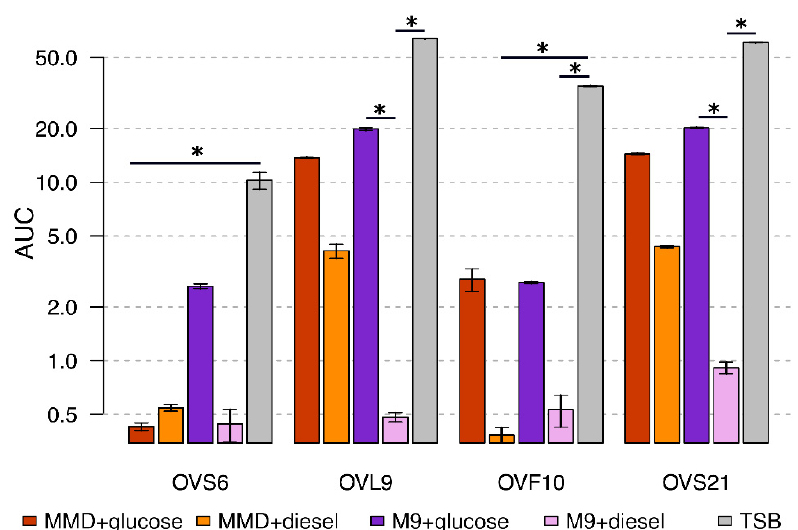
Figure 1. Diesel fuel degrading potential of the endophytes on liquid media. Values are expressed as the average values of area under the growth curve (AUC). Each color corresponds to a different growth medium, whereas bars represent standard errors. Asterisks show statistically significant differences between conditions ( p < 0.05).